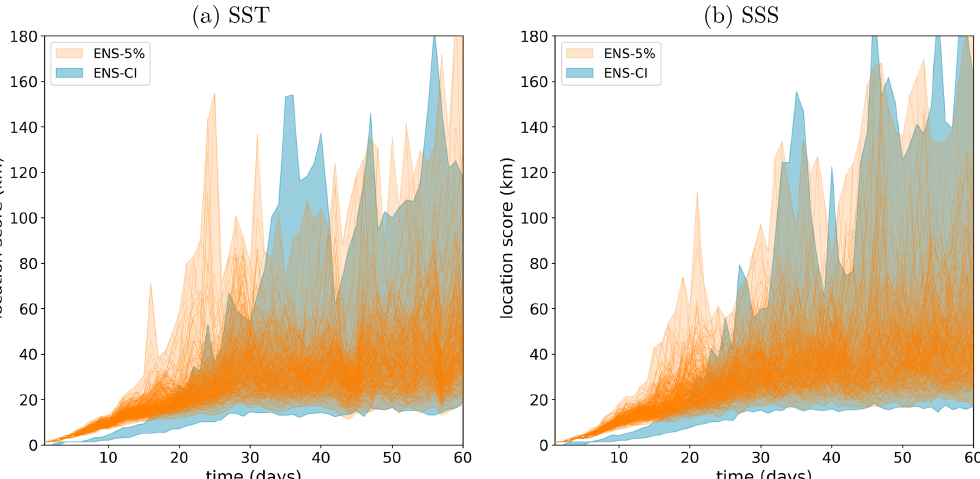
Figure 16. Time evolution of the location score ( y axis, in km) for (a) SST and (b) SSS, from two of the experiments: ENS-CI (no model uncertainty, in blue) and ENS-5% (larger model uncertainty, in orange). Only the minimum-to-maximum envelop of all the 20 × 19 individual location scores is represented for experiment ENS-CI as the individual 20 × 19 individual scores are already plotted in Fig. 14. The individual scores and the minimum-to-maximum envelope are superposed here for experiment